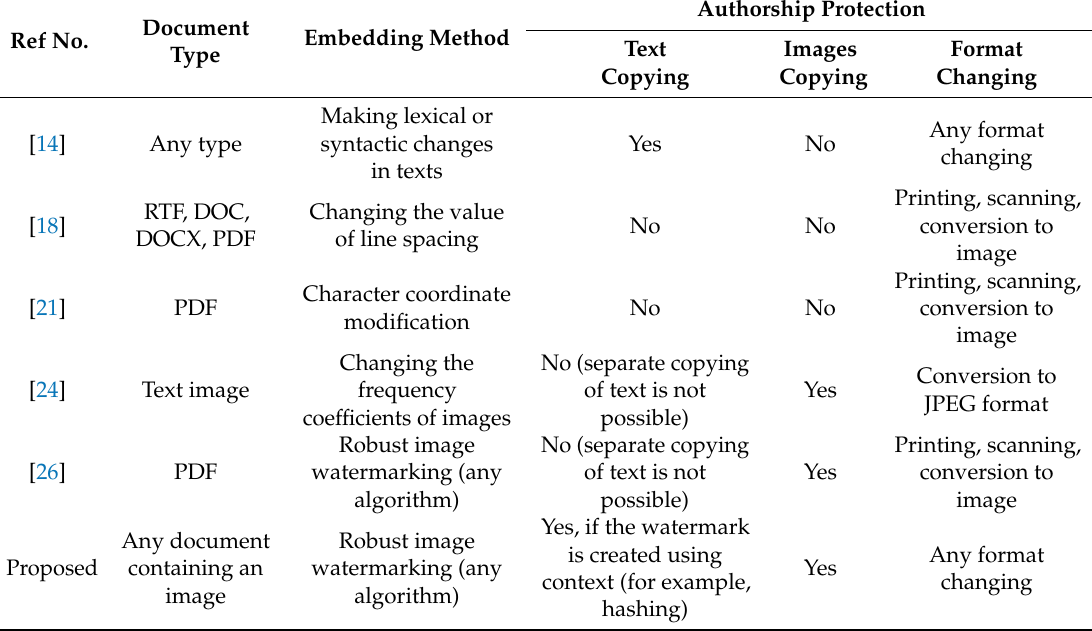
Table 7. Comparison of the state of the